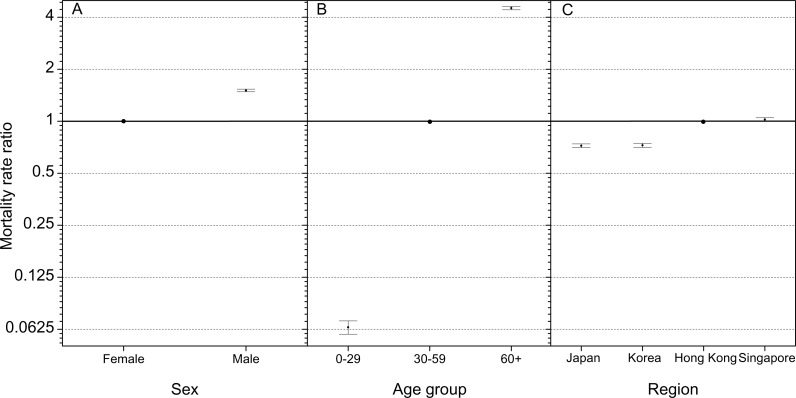
Mortality rate ratios of cutaneous melanoma by (A) sex, (B) age group, and (C) region in East Asia.The error bars represent 95% confidence intervals. 0–29: deaths aged 0–29 years; 30–59: deaths aged 30–59 years; 60+: deaths aged 60+ years. The mortality rate ratios of male, 30–59 years, and Hong Kong are set to reference group.